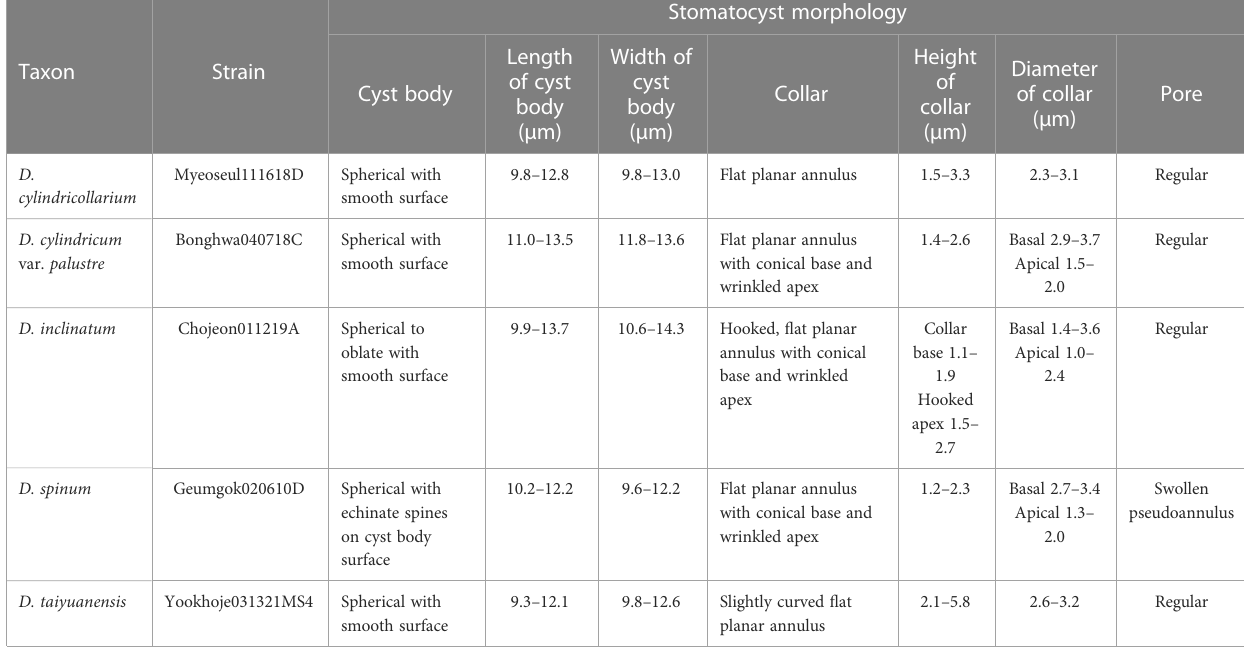
TABLE 2 Summary of newly recorded stomatocyst morphological characteristics of Dinobryon species.